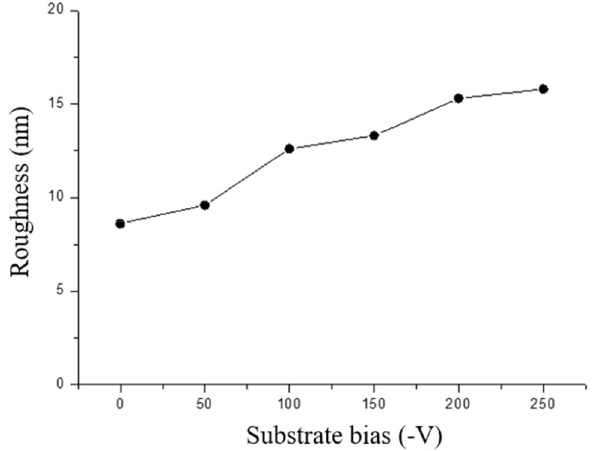
Figure 7. Surface roughness of sputtered Cu films deposited with various substrate biases.